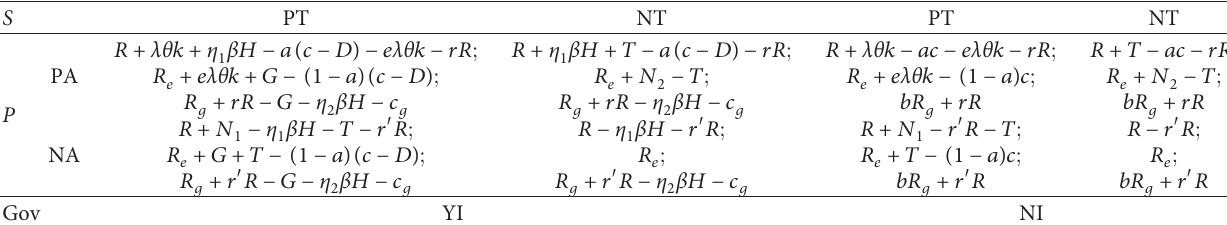
Table 1: Payment matrix of the evolutionary game of